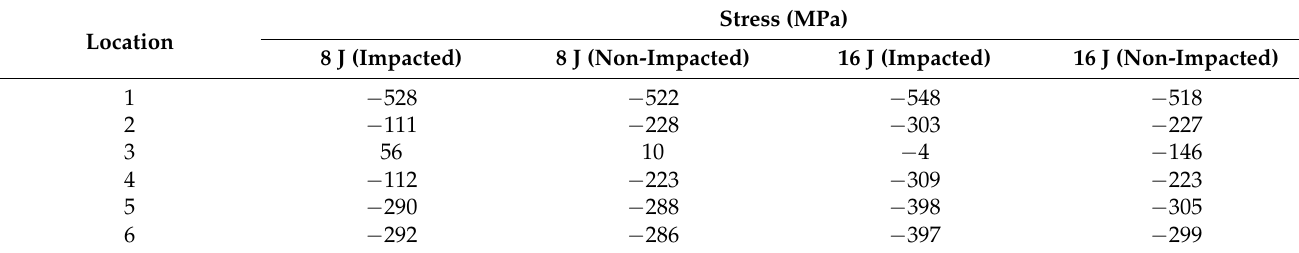
Table 6. σ 11 on aluminum layer of GLARE